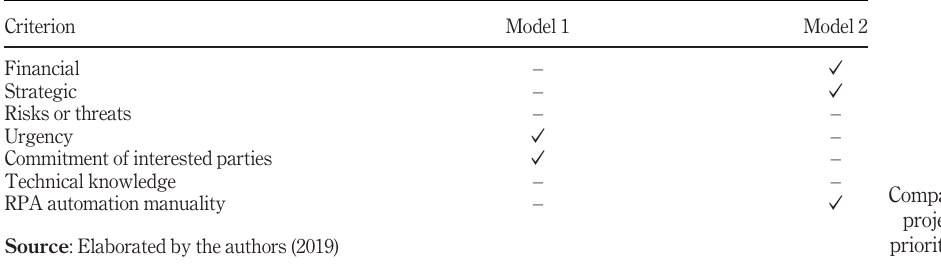
Table 2. Comparison